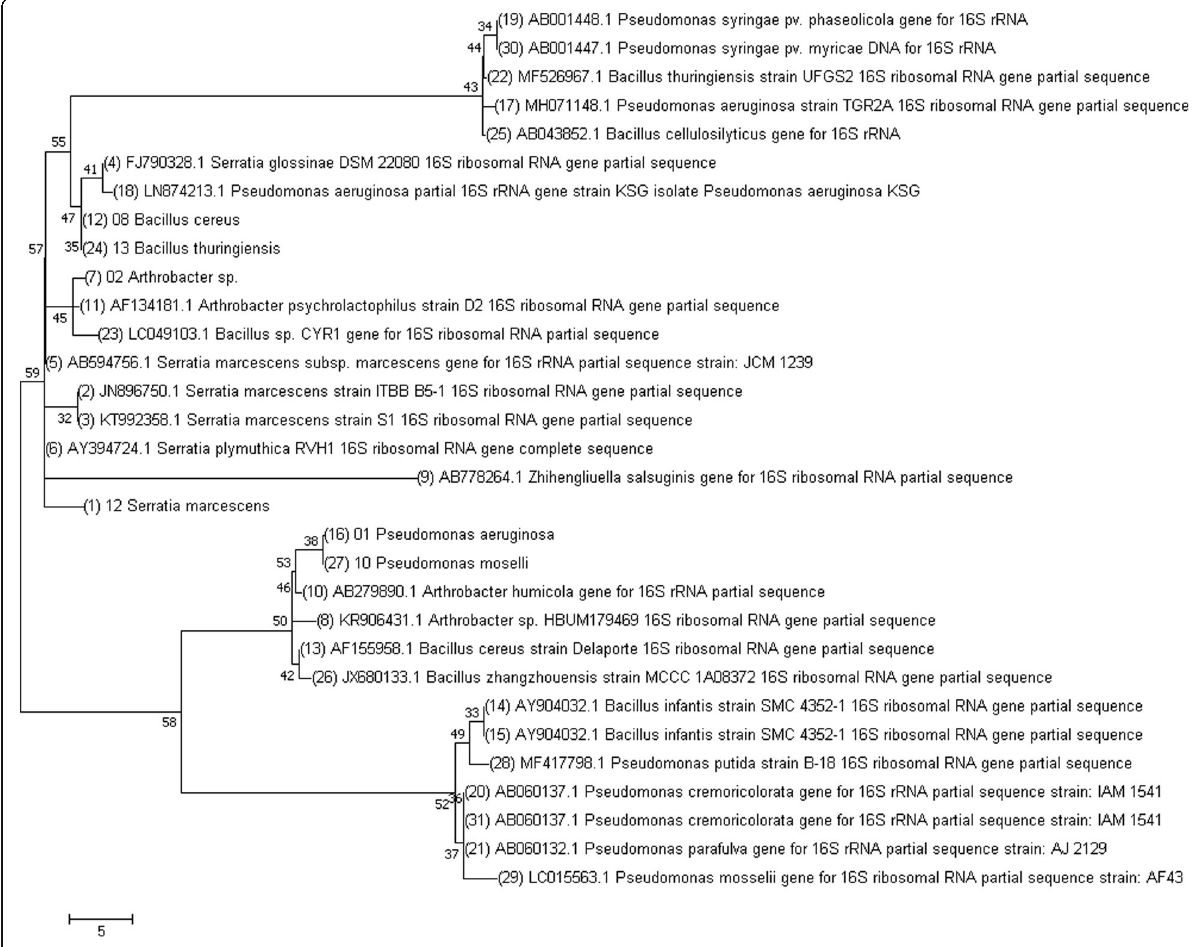
Fig. 1 Phylogenetic tree analysis of 16SrRNA gene by using Tamura-Nei